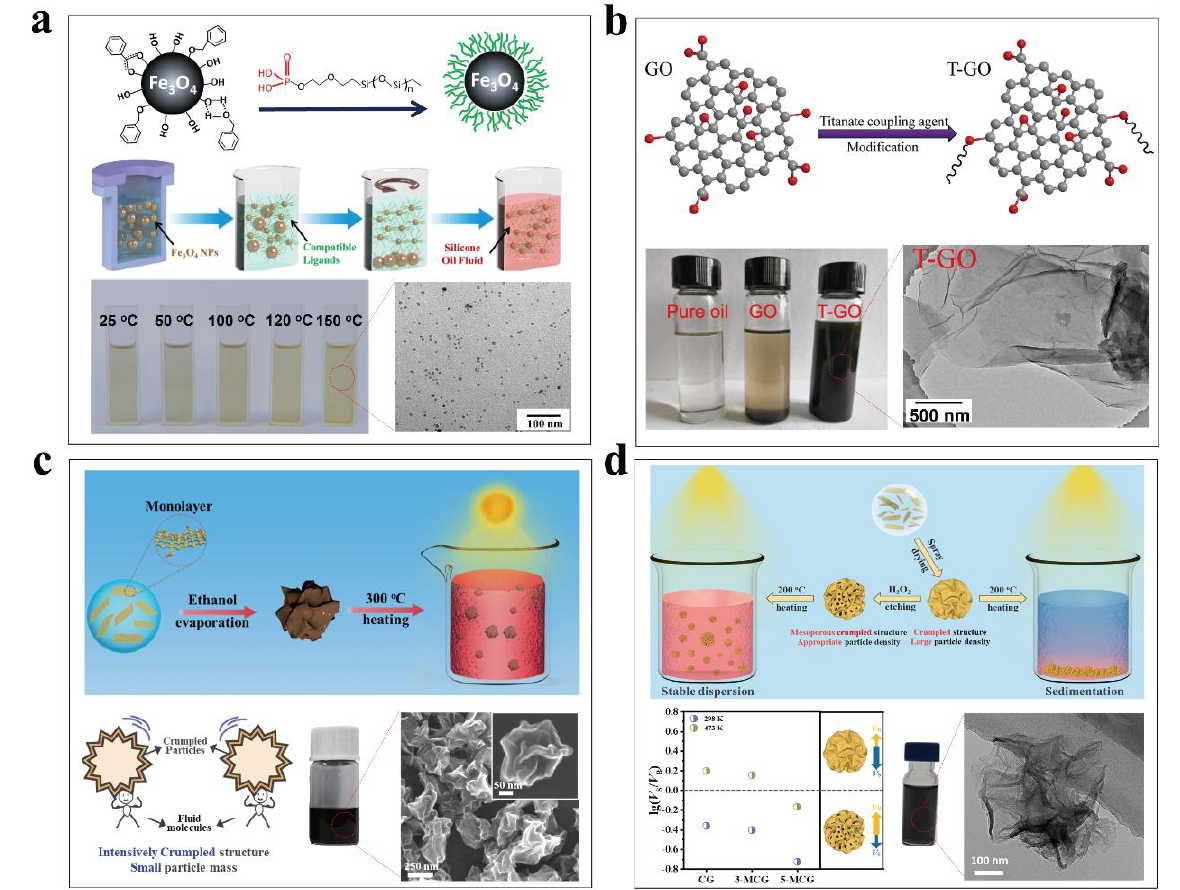
Figure 5. ( a ) Steric stabilization of Fe 3 O 4 nanoparticles through surface grafting with phosphate- terminated PDMS ligands, which enable their stable uniform dispersion within silicone oil (( a ) reprinted/adapted with permission from Ref.